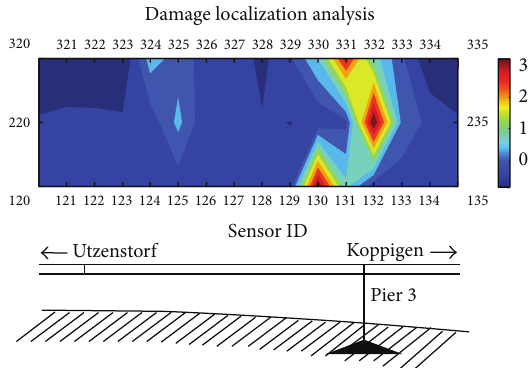
Figure 22: The shifted distances of damage pattern 6 feature vectors from normal pattern feature vectors.